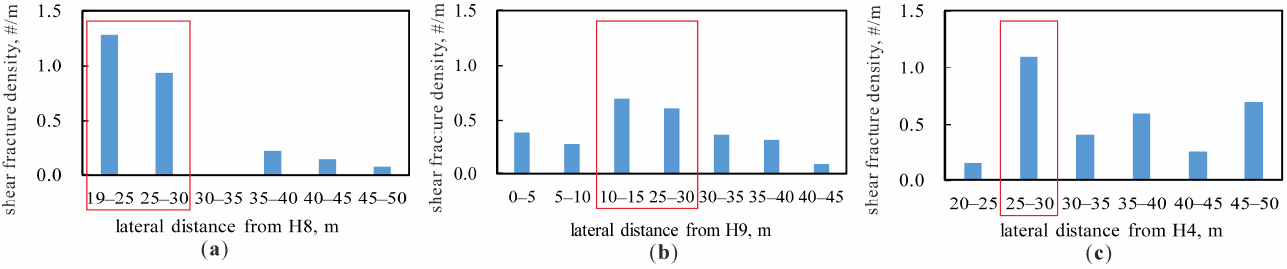
Figure 12. The distribution of shear fracture density with respect to the lateral distance from adjacent wells. ( a ) H8; ( b ) H9; ( c ) H4.